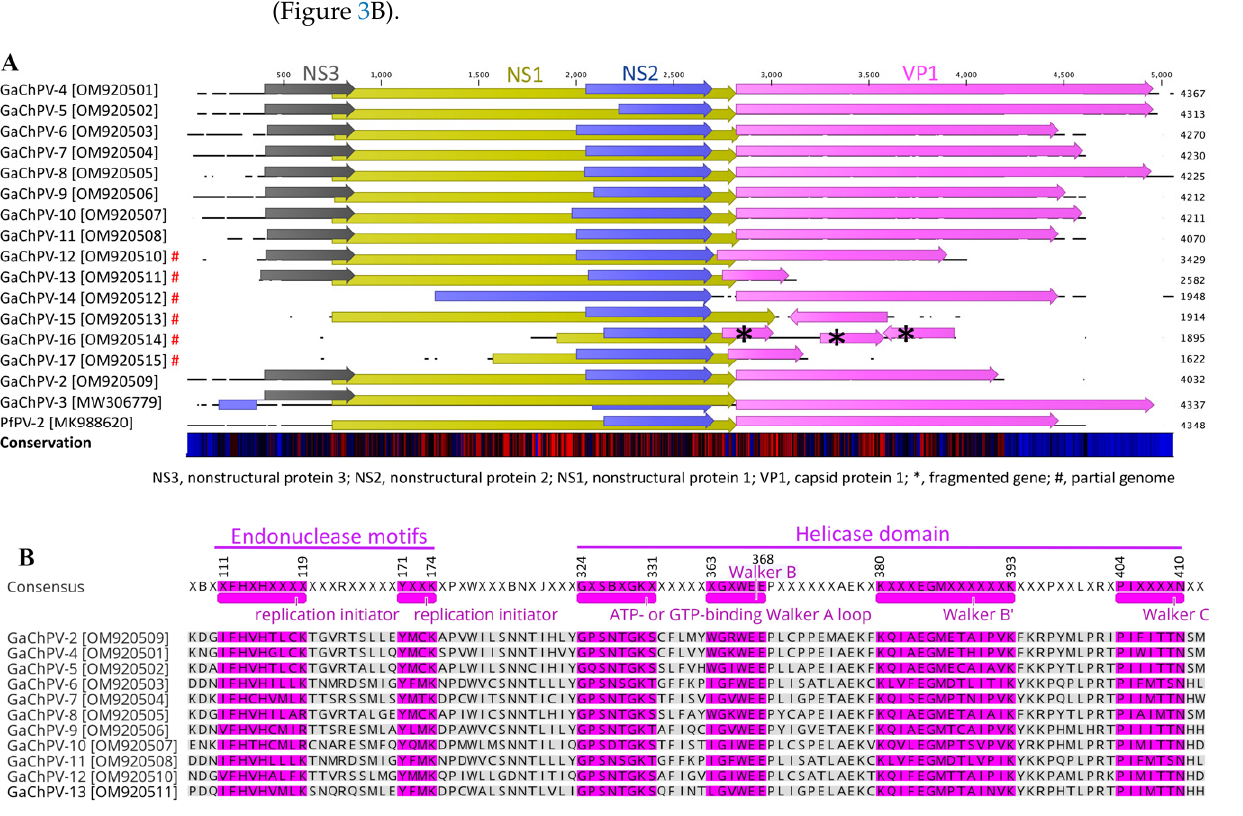
Figure 3. A schematic illustration of the selected avian chaphamaparvoviruses. ( A ) A schematic map of the galliform chaphamaparvoviruses (GaChPVs) sequenced in this study (GenBank Accession No. OM920501–OM920515) compared to GaChPV-3 (GenBank Accession No. MW306779) and the peafowl parvovirus 2 (PfPV-2, GenBank Accession No. MK988620), using the CLC Genomic Workbench (version 9.0.1). The arrows symbolise chaphamaparvovirus genes and open-reading frames (ORFs) predicted to code for proteins, indicating their transcriptional direction. Each gene or ORF is colour coded. The bottom graph represents the sequence conservation among the aligned selected sequences at a given coordinate at each position in the alignment. The colour gradient reflects the conservation of that position in the alignment. Red presents 100 conserved regions across all viruses, black is 50 conserved regions, and blue is less than 50 conserved regions. * = denotes genes fragmented; # = denotes partial genomes. ( B ) Alignment of conserved domains of nonstructural protein 1 (NS1) from 11 GaChPVs sequenced in this study.